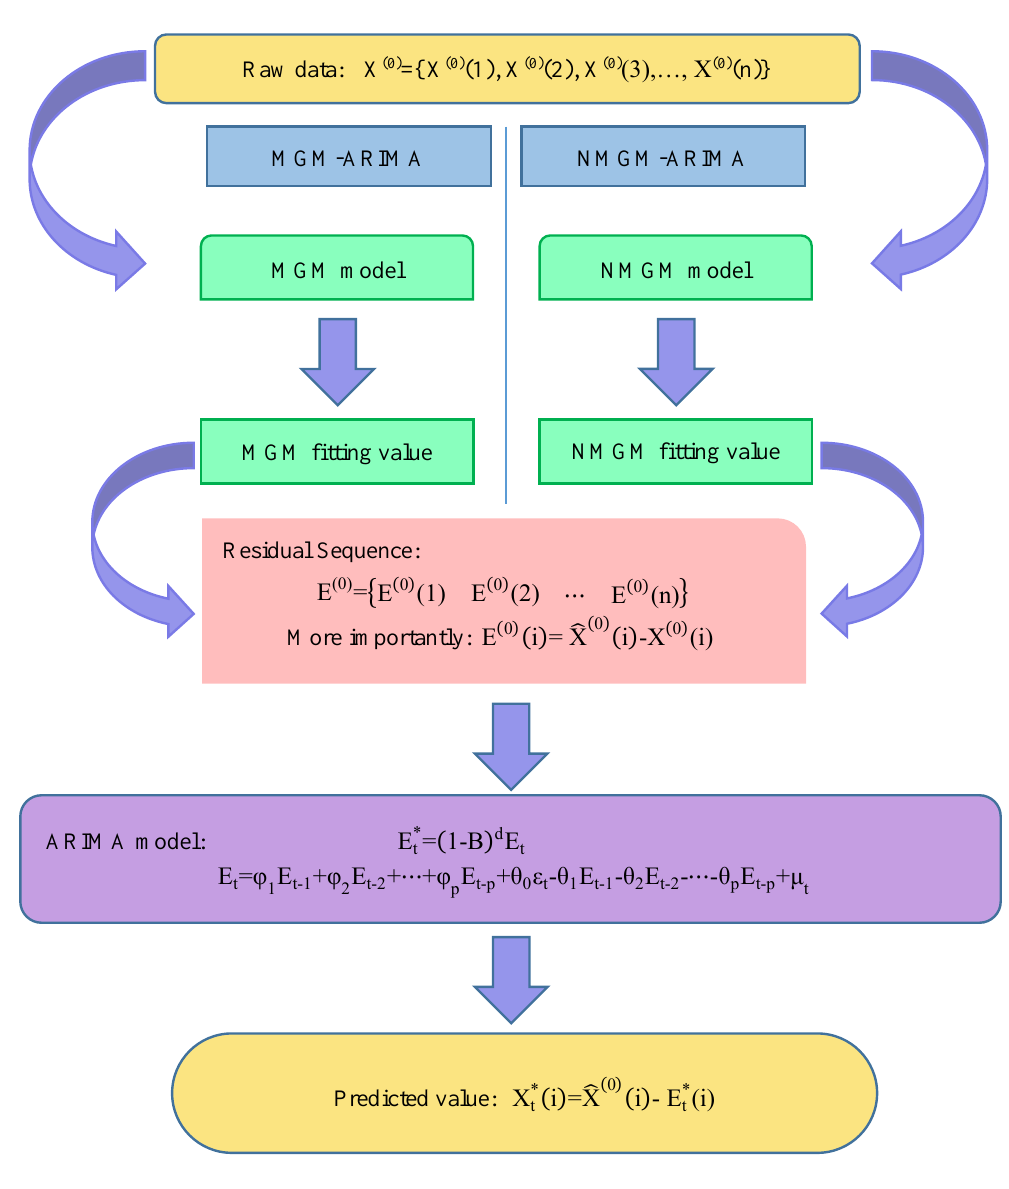
Figure 1. The Forecasting Process of metabolic grey model-Auto Regressive Integrated Moving Average Model (MGM-ARIMA) and non-linear metabolic grey model (NMGM)-ARIMA.